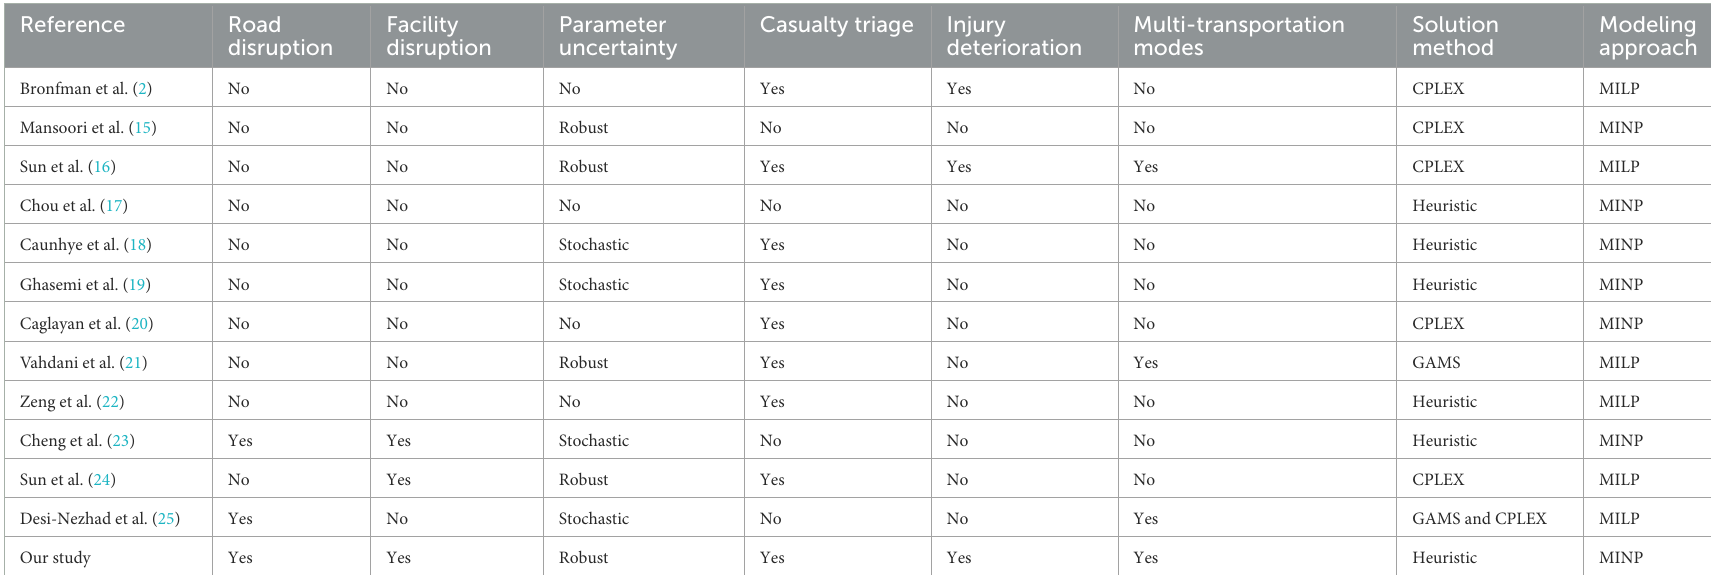
TABLE 1 Summary of relevant